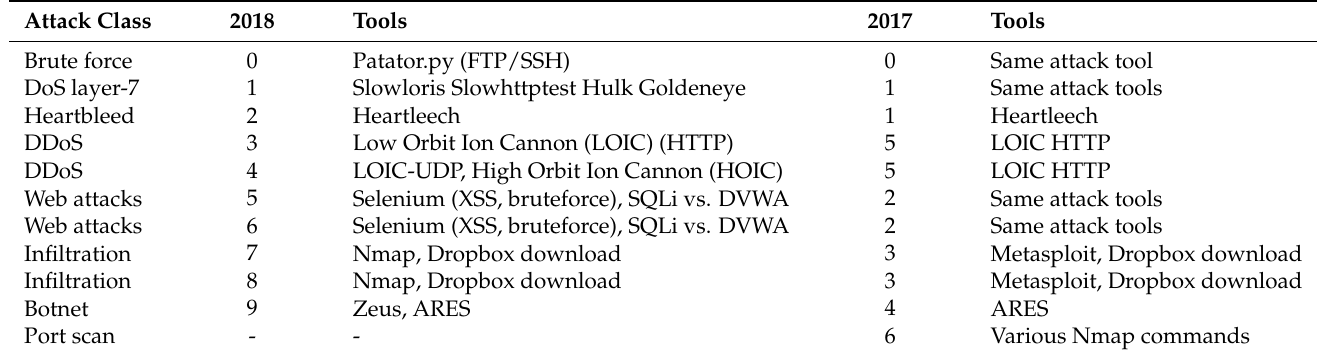
Table 6. Mapping of the subsets of CSE-CIC-IDS2018 to their counterpart in